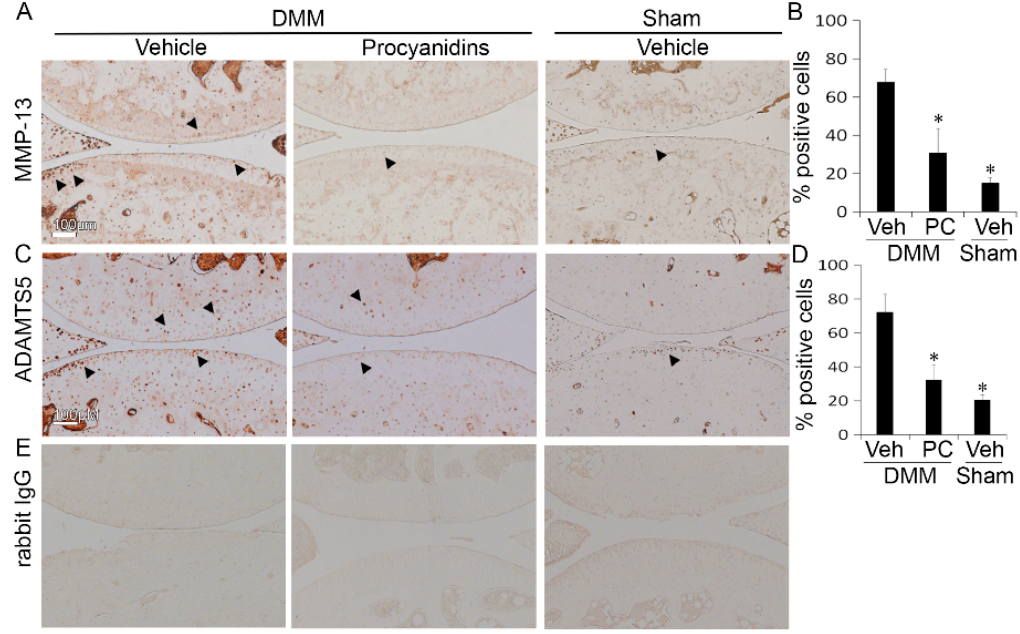
Figure 3. Oral administration of procyanidins reduced protein levels of matrix metalloproteinase (MMP)-13 and a disintegrin and metalloproteinase with thrombospondin motifs 5 (ADAMTS5) in articular cartilage of mice subjected to DMM surgery. Immunohistochemical staining of MMP-13 ( A ); and of ADAMTS5 ( C ) and percentage of positive cells ( B , D ) in the articular cartilage of mice subjected to DMM and treated with procyanidins (PC) was significantly reduced compared to that in mice subjected to DMM and treated with vehicle (Veh); ( E ) representative staining of tissue sections with isotype control (rabbit immunoglobulin G, IgG). Scale bar = 100 µm. * p < 0.05 by one-way ANOVA with Tukey post-hoc test; n = 4/group. Arrows indicate representative chondrocytes with positive immunostaining for MMP-13 ( A ) or ADAMTS5 ( C ).